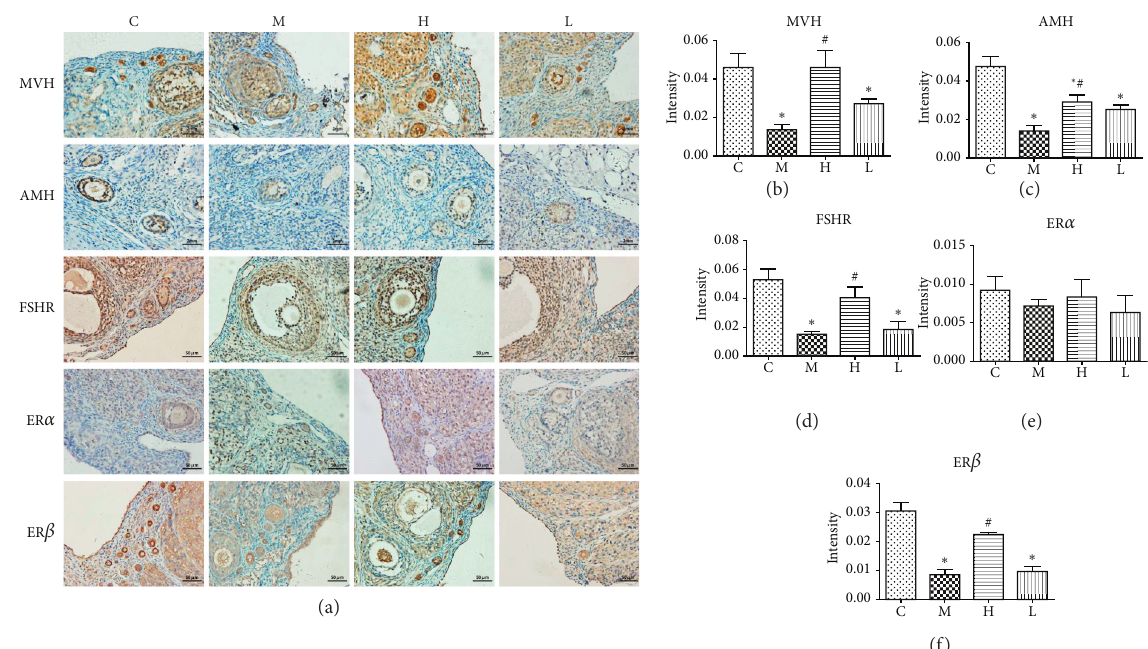
Figure 4: Immunohistochemical analysis of the expression of various biomarkers for ovarian reserve in each group. ∗ : significant compared with group (C) ( p < 0 . 05 ) ; #: significant compared with group (M) ( p < 0 . 05 )